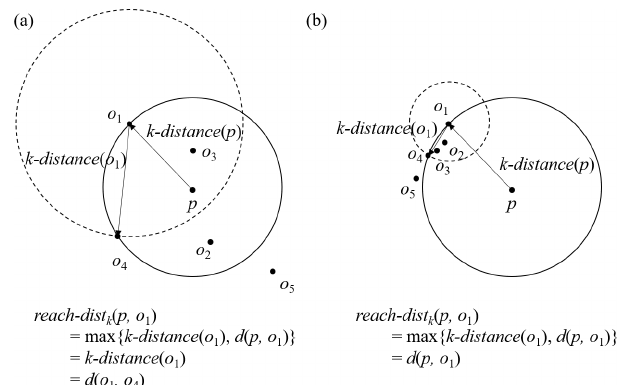
Figure 3. Schematic diagrams of reach-dist k (p,o) with k = 3 for (a) uniformly distributed data and (b) data with an asymmetrical